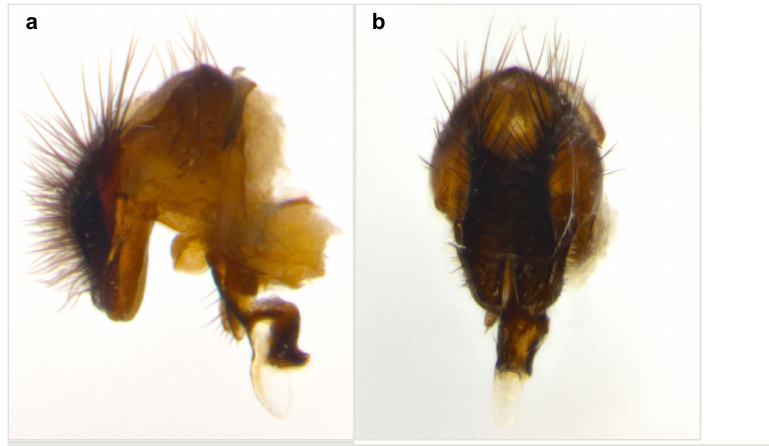
c Figure 8. Male terminalia of Calolydella bifissus sp. n. ; a–c : paratype, voucher n.